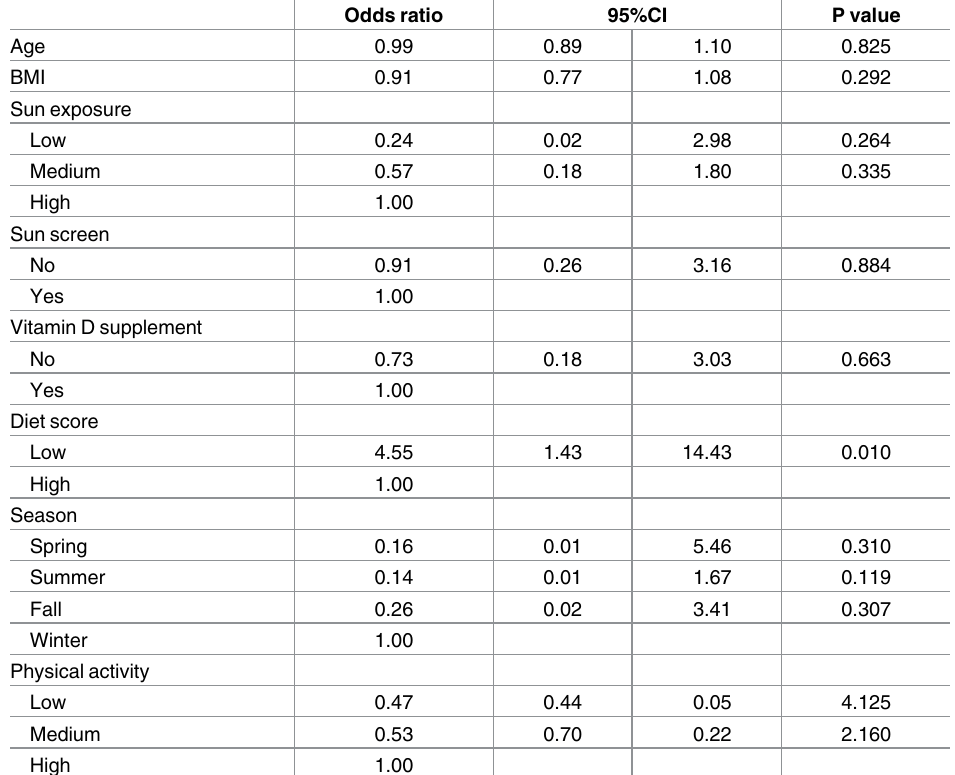
Table 3. Logistic regression for risk factors of low vitamin D status